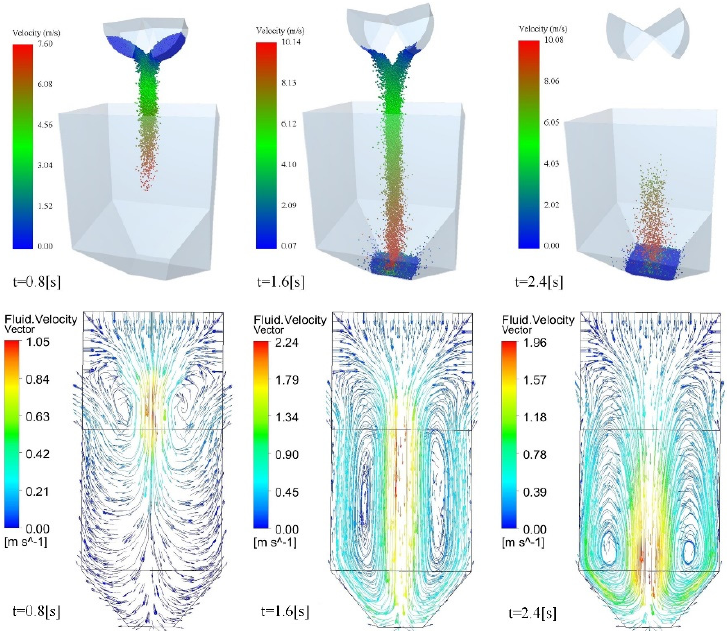
Figure 4. Motion trajectory and velocity distribution of particle flow field and air flow field.